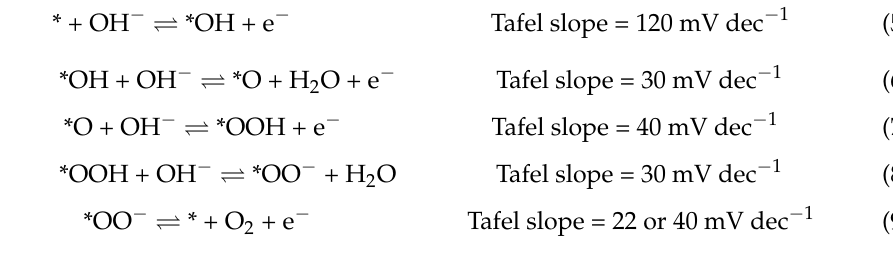
Table 1. Comparison of the OER performance of the best representative electrocatalysts in alkaline electrolytes. Electrocatalyst KOH Concentration